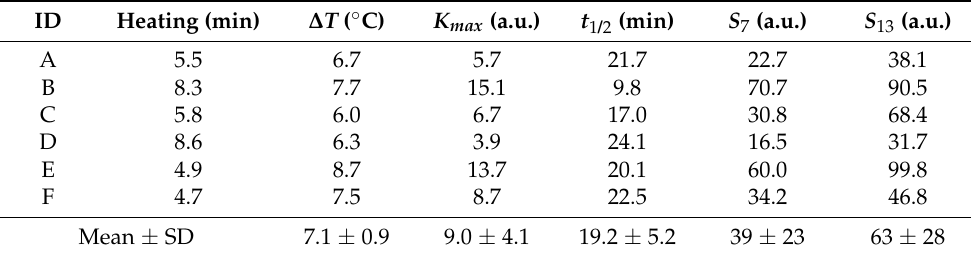
Table 3. Parameters of the perfusion reaction to local skin heating for 13 min. Table 2. Parameters of the perfusion reaction to local skin heating for 7 min.